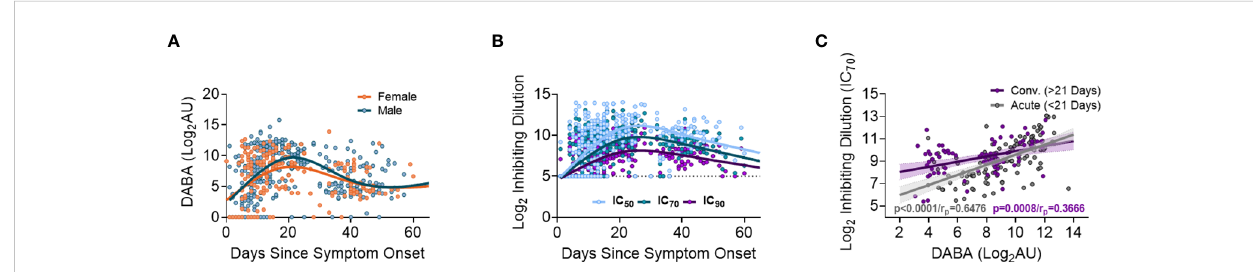
FIGURE 2 Association between anti-RBD as well Ab neutralisation responses with days since disease onset. (A) Anti-RBD binding in relation to days since disease onset and split into females (orange) and males (blue). The lines (females orange and males blue) show the spline/LOWESS curves indicating the overtime evolutionary trend of the data. (B) Neutralisation antibody responses depict in relation to days since disease onset and curves representing the spline/LOWESS for the IC 50 , IC 70 and IC 90 values indicating the overtime evolution trend. (C) Association between anti-RBD and neutralisation responses (IC 70 ). Spearman correlation test (P<0.0001/r p =0.6476), in acute infection (under 21 days) and (P<0.0001/r p =0.3666) in convalescence (over 21 days).